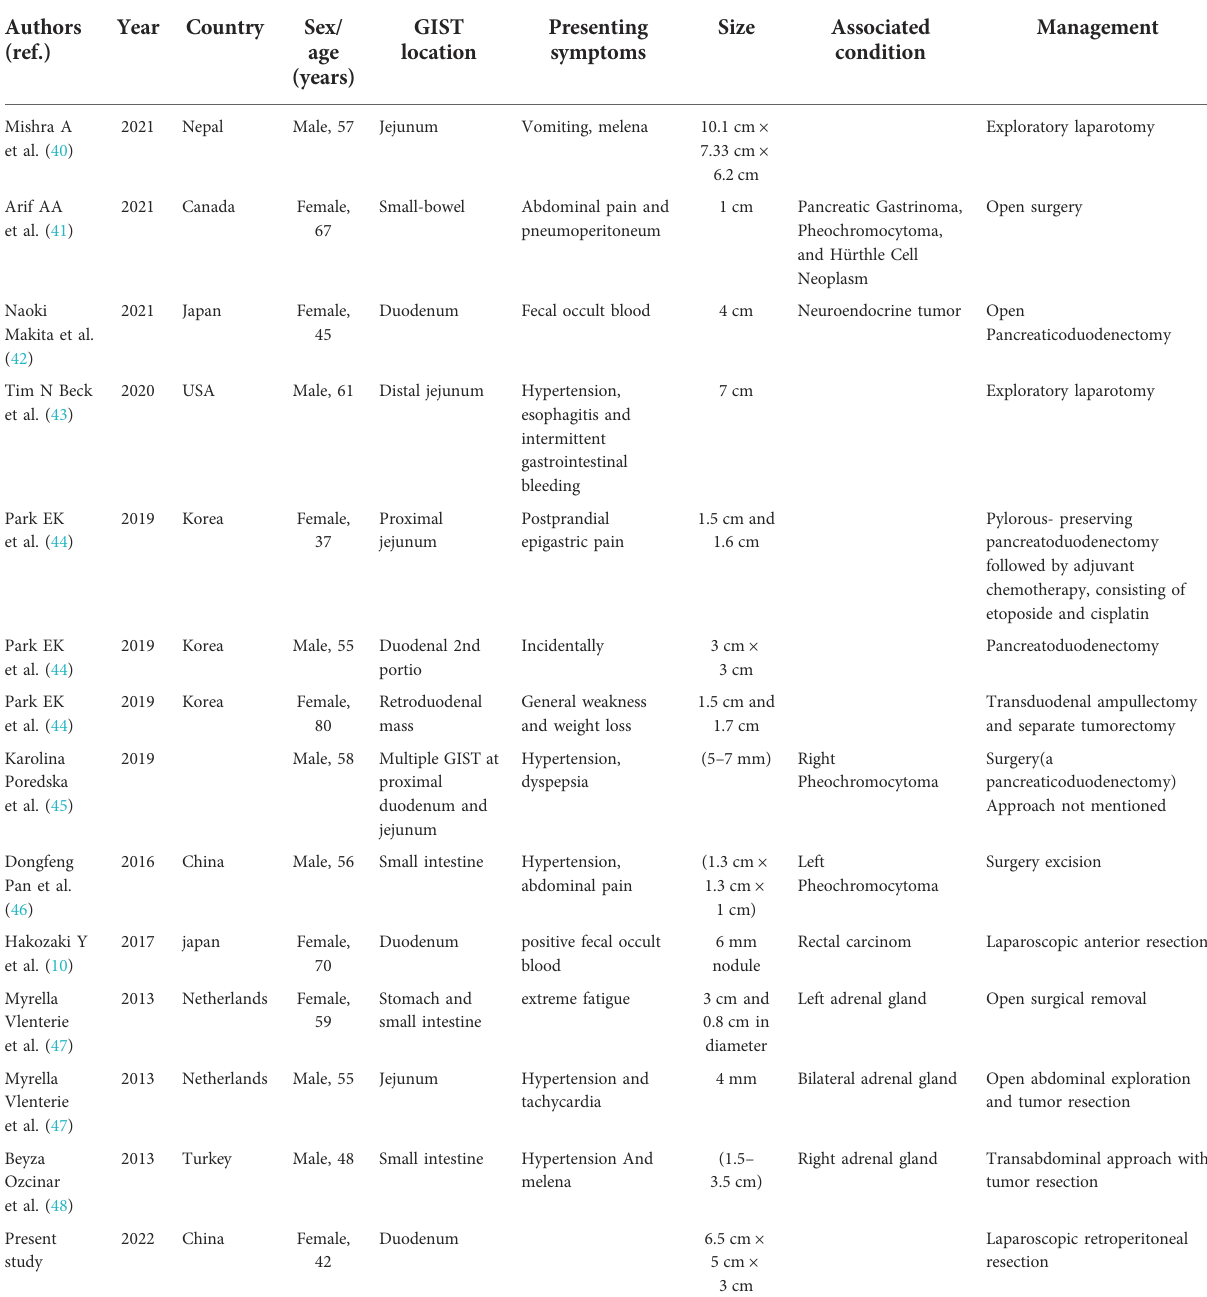
TABLE 2 List of reported cases of gastrointestinal stromal tumor in NF1. Authors